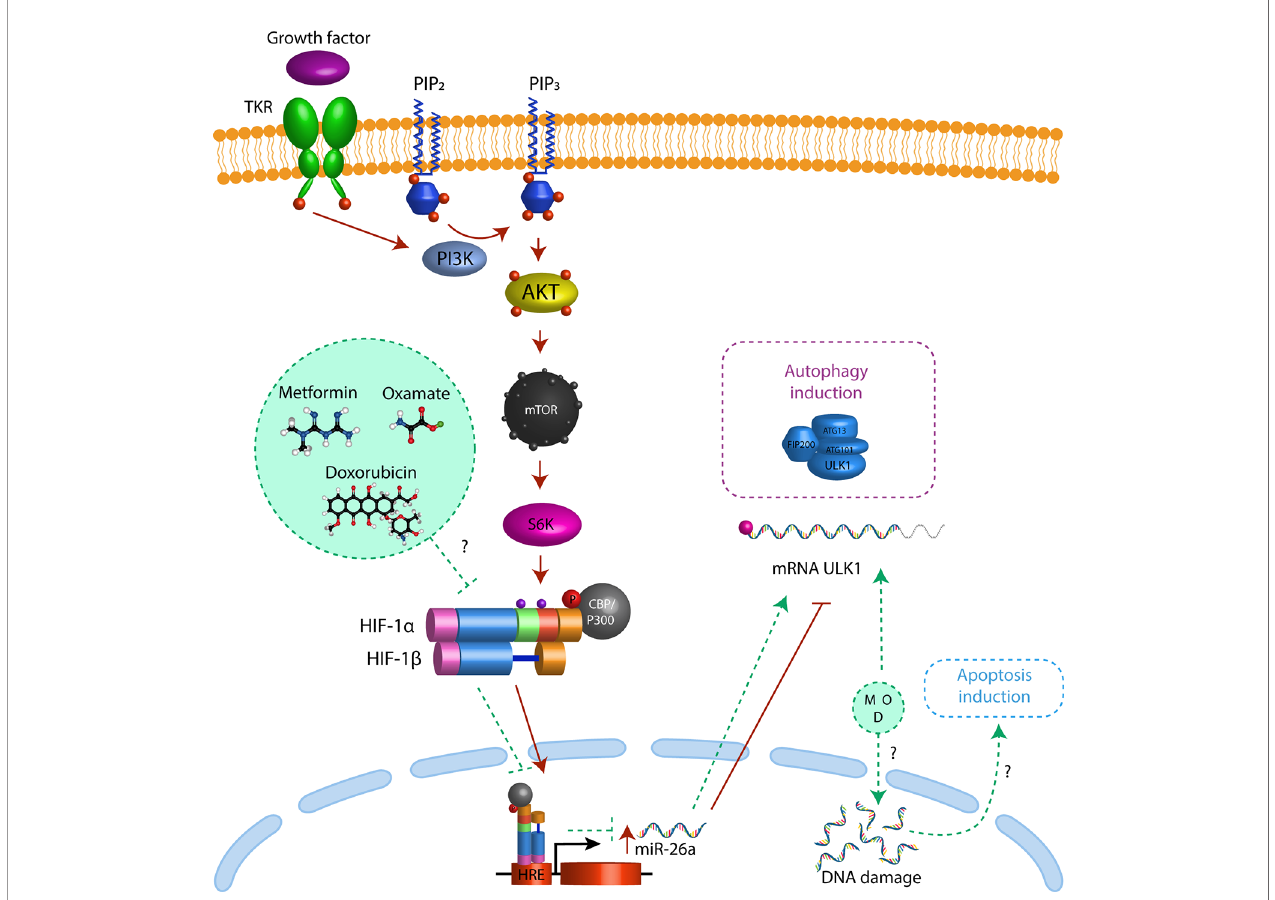
FIGURE 6 | Triple therapy induces autophagy through mir-26 inhibition. Triple therapy (metformin, sodium oxamato and doxorubicin (green circle) diminish the levels of HIF1 a (green dash line), resulting in a decrease in mir-26a expression (green dash line) and the release of ULK1 inhibition driving to autophagy (purple dash rectangle) and apoptosis induction (blue dash rectangle). Besides in cancer cells the PI3K-Akt pathway regulates HIF1 a expression by activation of mTORC1 (red arrows), promoting their translocation to nucleus, resulting in over-expression of mir-26a (red arrow) inhibiting the mRNA translation of ULK1 (red dash line) and autophagy and